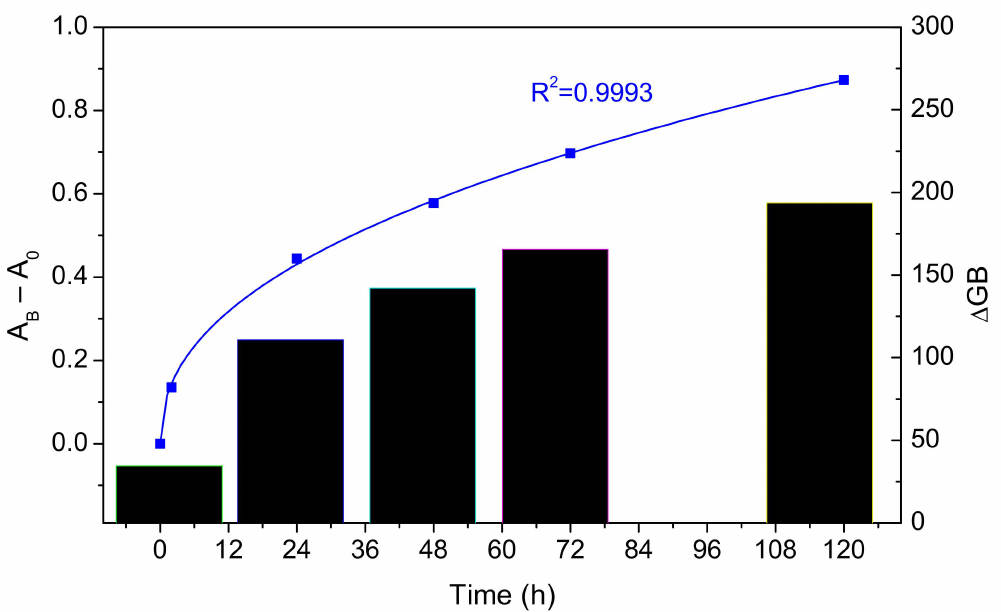
Figure 5. Evolution of the color change (black columns) and of the colorimetric absorbance (blue dots and line) with the time of exposure of polyDMAEMA-impregnated paper sheets to